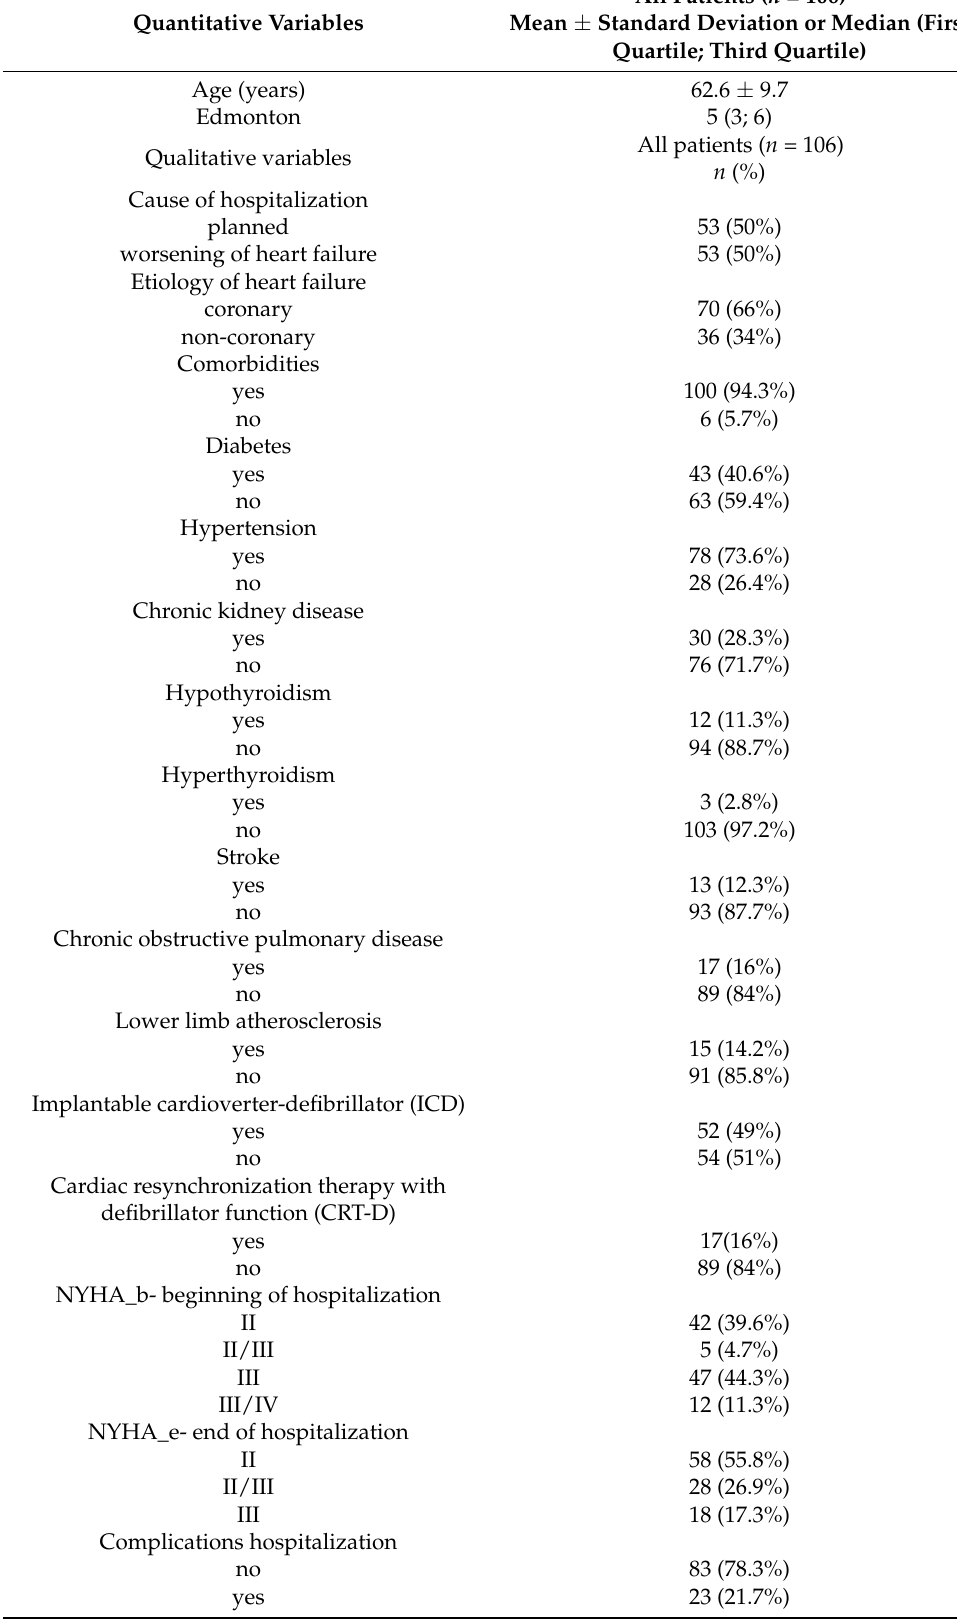
Table 1. Characteristics of the study